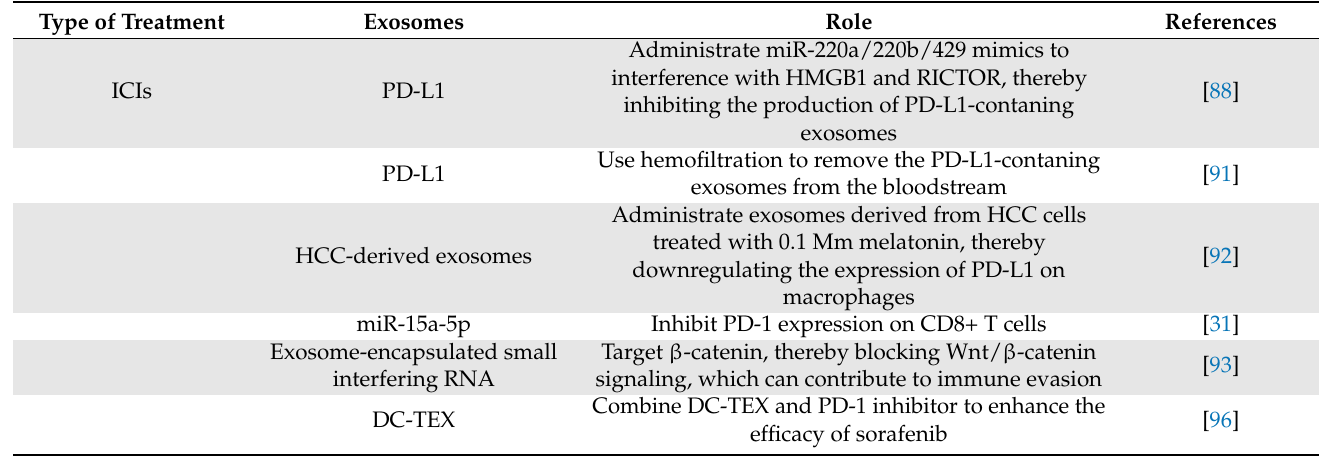
Table 1. Potential role of exosomes in improving the efficacy of HCC